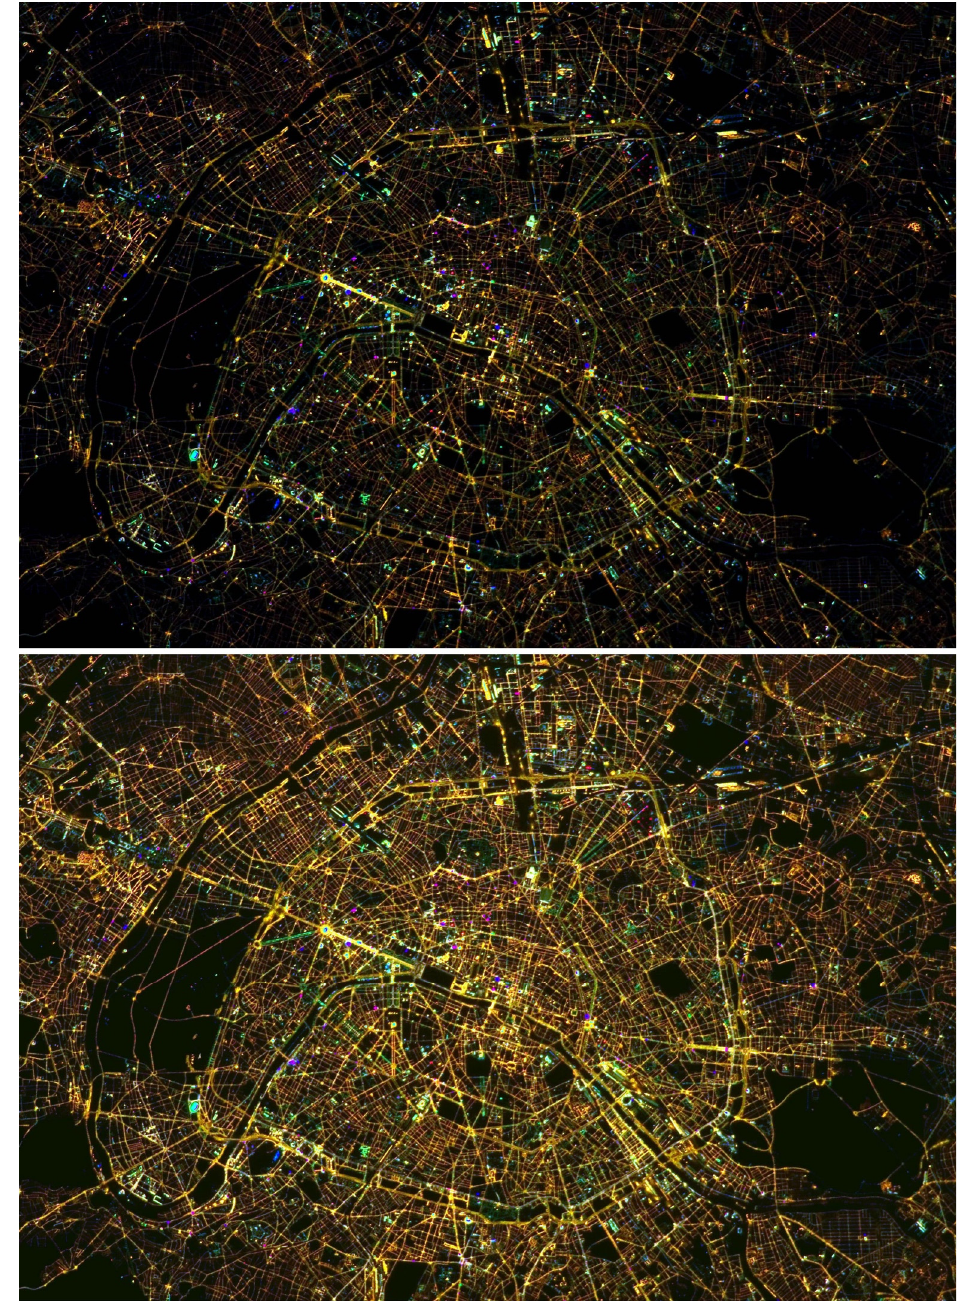
Figure 9. WYR and Log 10 WYR fraction composites for Paris illustrate the diversity of high luminance colored point sources superimposed on the pervasive low luminance warm spectrum street